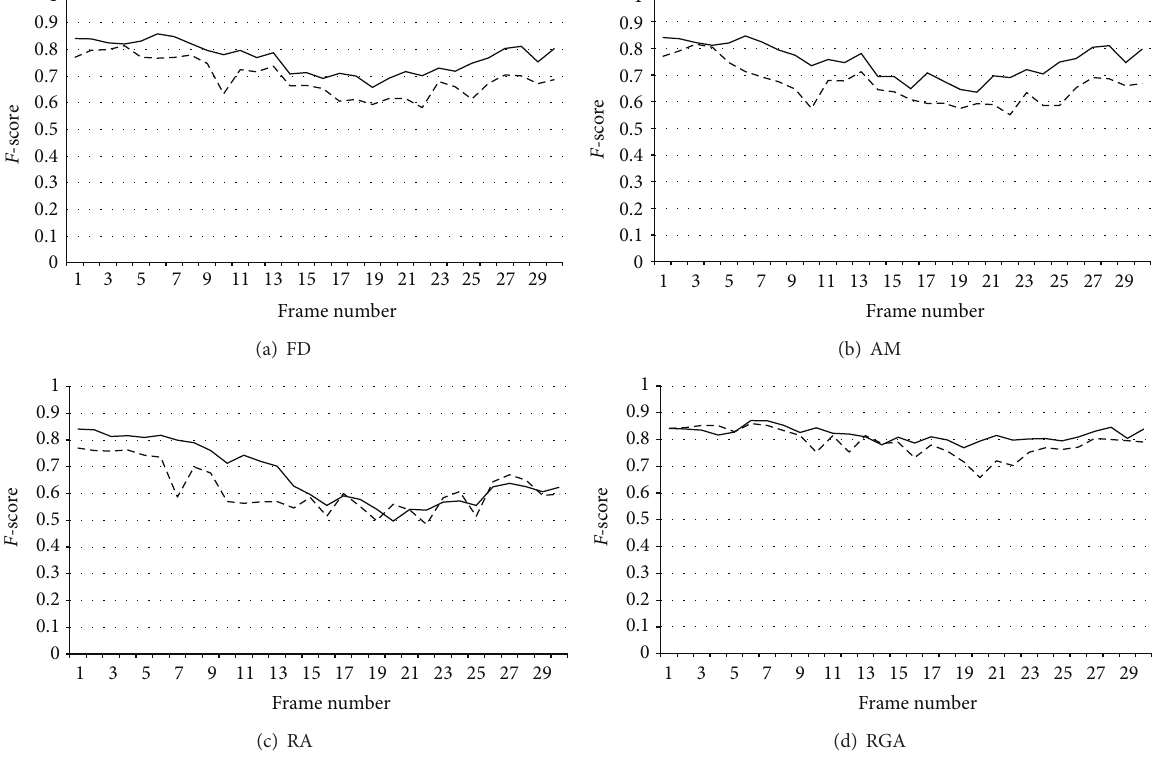
Figure 7: Graph of F- score versus frame number for outdoor sample.